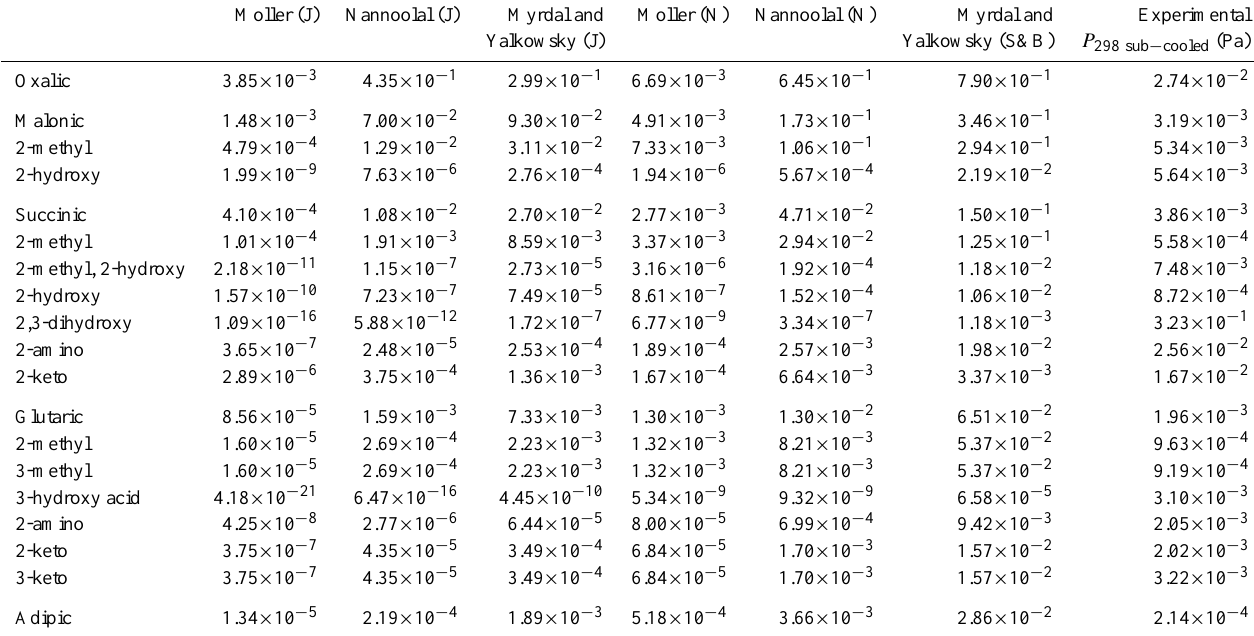
Table 7. Vapour pressure results for estimation methods, all P 298 K are measured in Pa in the sub-cooled liquid state. (J) = Joback et al. (1987) T b , (N) = Nannoolal et al. (2004) T b and (S&B) = Stein and Brown (1994) T b . The experimental data in the final column are measured over a range of 20K with maximum errors of ±